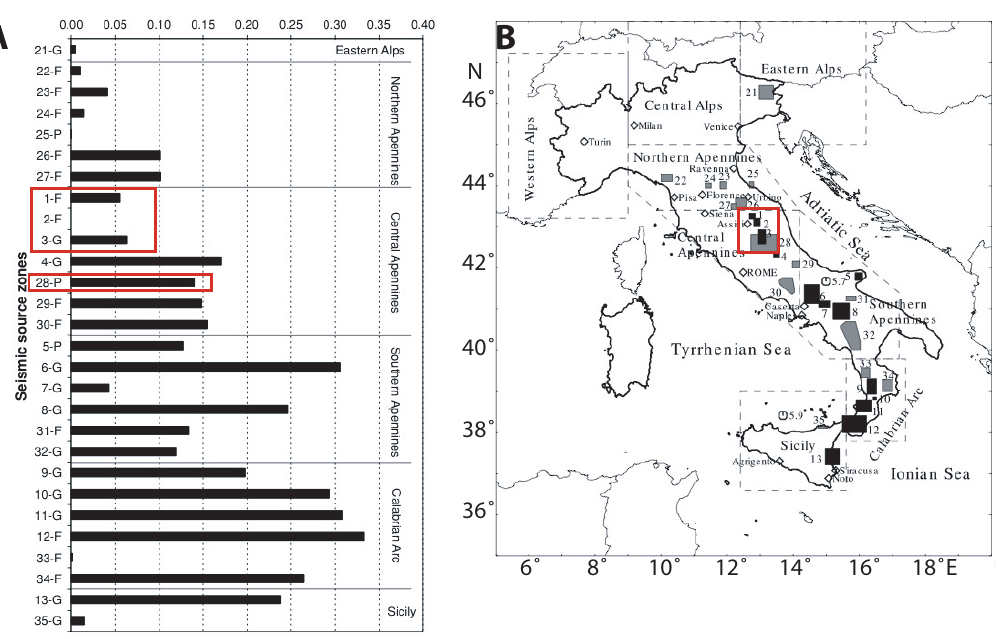
Fig. 3. Romeo’s (2005) forecasts of M 6.0+ earthquakes in the next 30 years. A) Probabilities for each seismo- genic structure. B) Map of seismogenic structures; different colors (gray and black) stand for different reliabili- ty (see Romeo (2005) for further information). In both panels, red boxes mark the Umbria-Marche